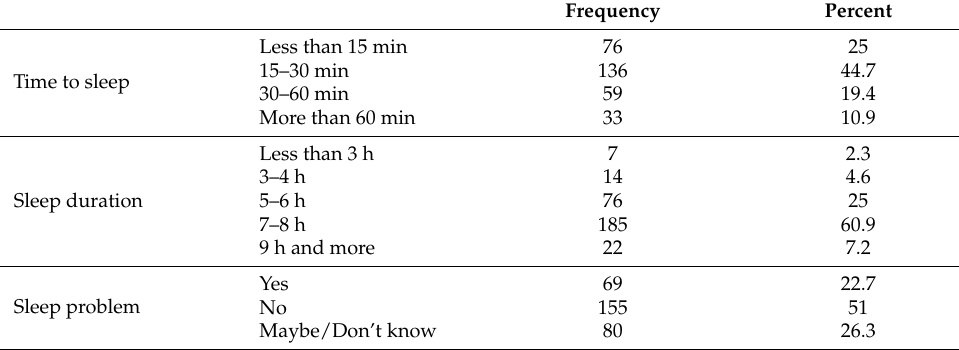
Table 7. Sleep habits of the